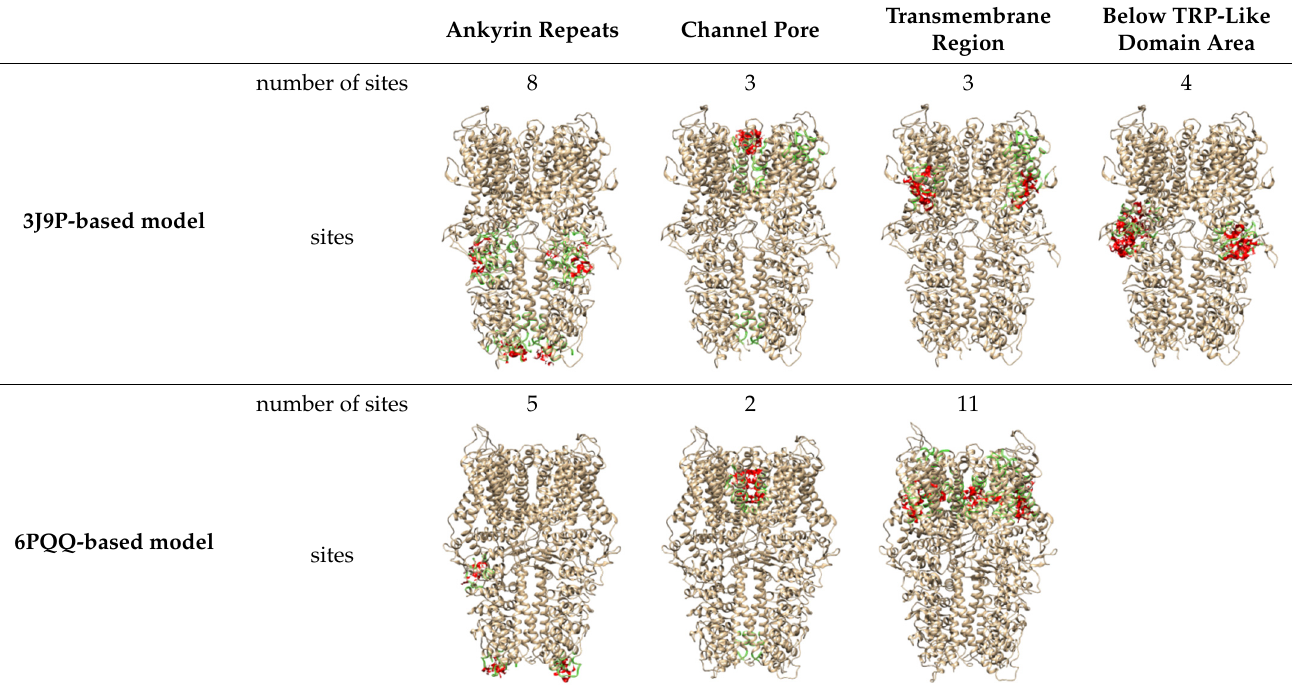
Table 5. Summary of all predicted binding sites for models based on 3J9P and 6PQQ. Sites excluded from further investigation are marked in red. The most prevalent binding site, consistent with experimental reports, is marked in green.